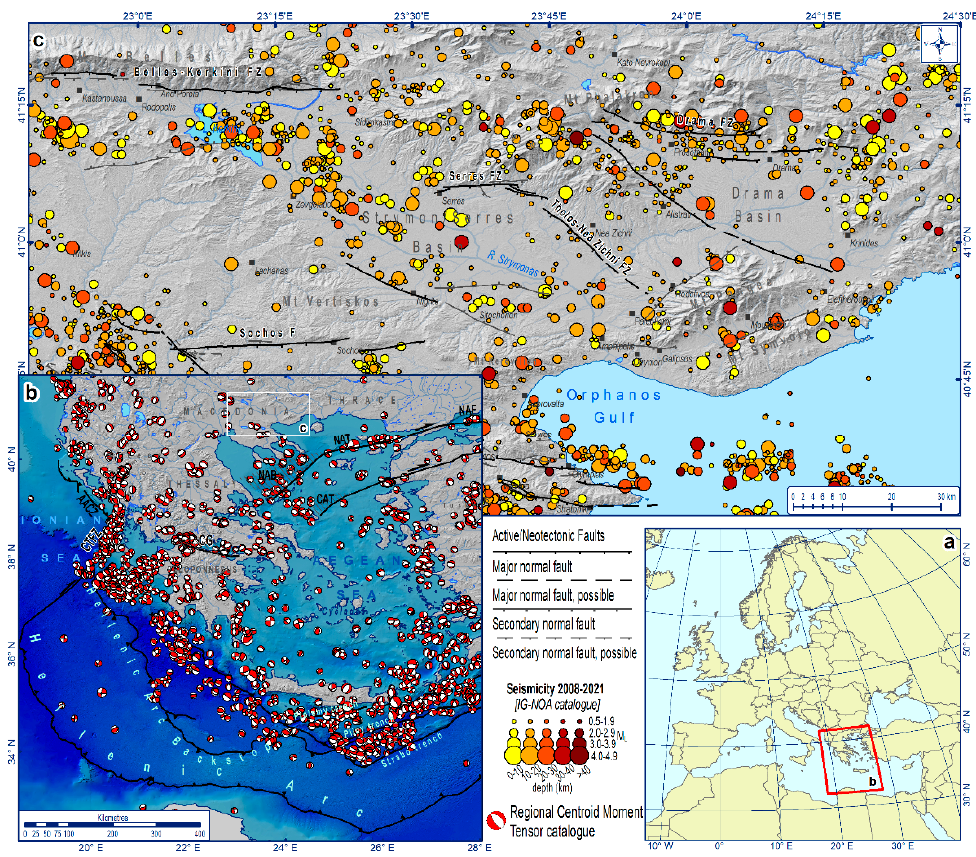
Figure 1. ( a ) Map showing the location of inset map ( b ). ( b ) Map of the principal tectonic